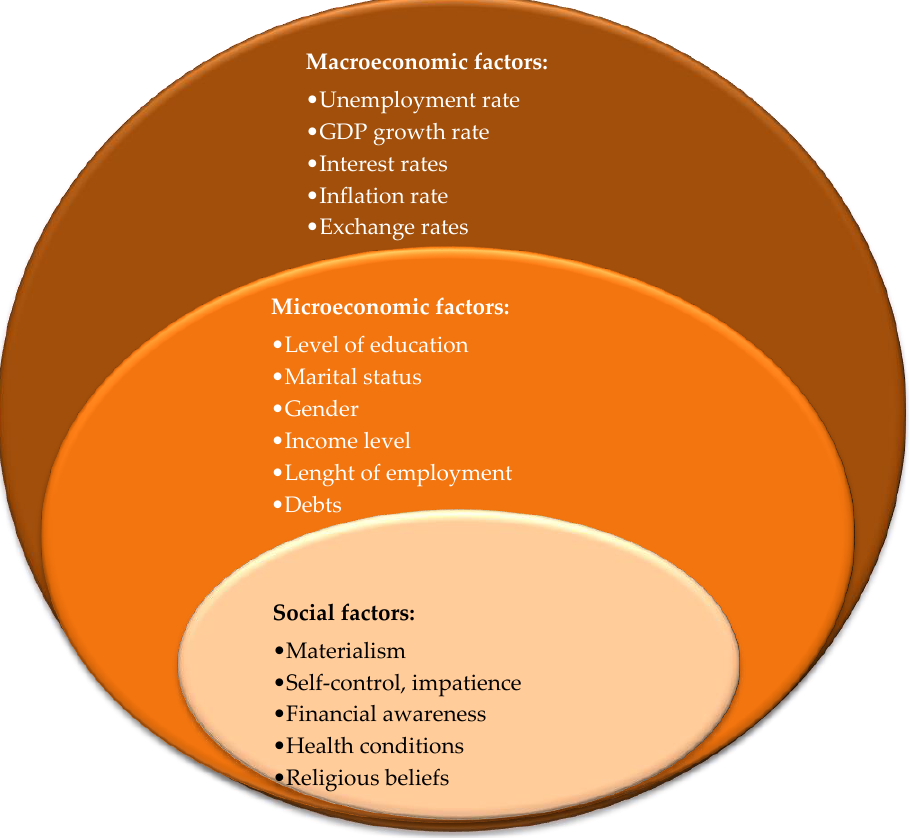
Figure 1. The classification of personal bankruptcy causes. Source: based on the author’s own studies.